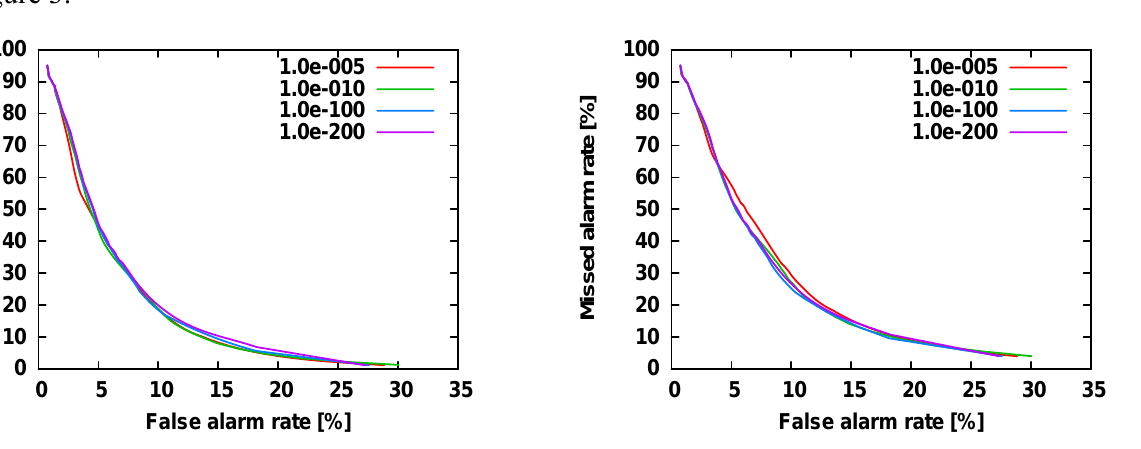
Figure 9. ROC curves of internal masquerader detection (a) and external masquerader detection (b) for the minimum probability. All other parameters are the same as those in Figure